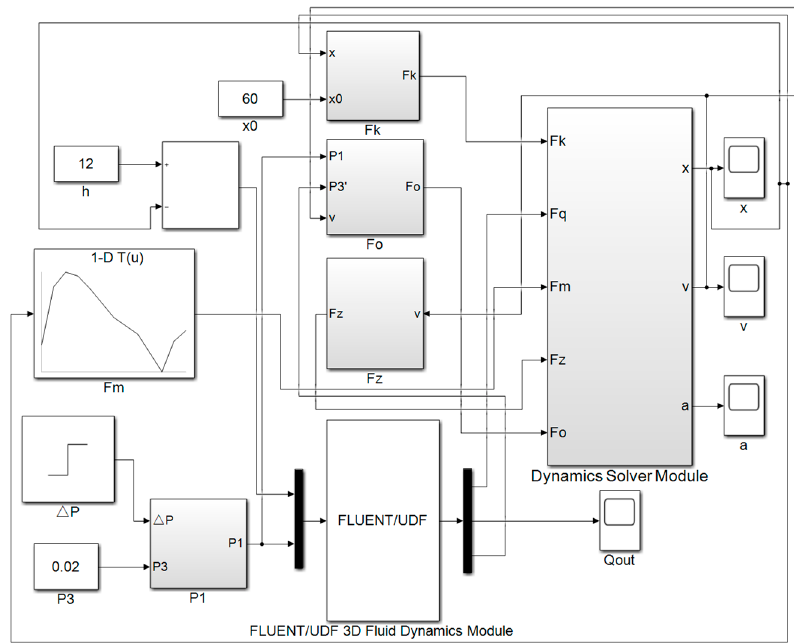
Figure 5. MATLAB/Simulink–FLUENT/UDF co-simulation model.